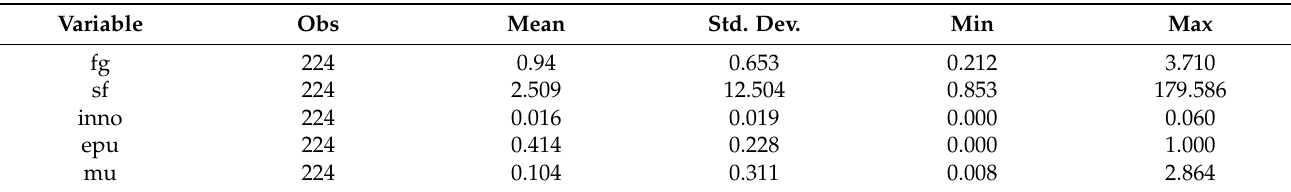
Table 4. Descriptive statistics of variables.